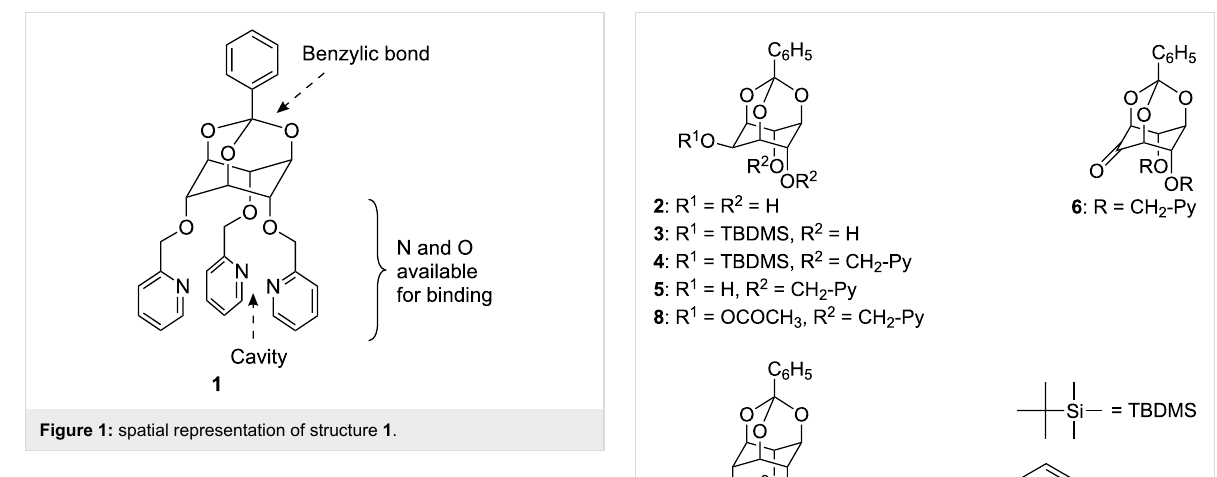
oxidation/reduction sequence [8,18,19], selective protection